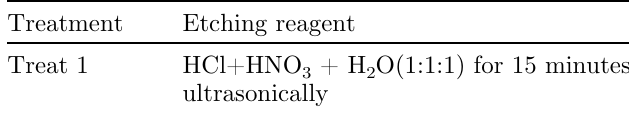
Table 2. Chemical pretreatments of WC – Co substrates. Treatment